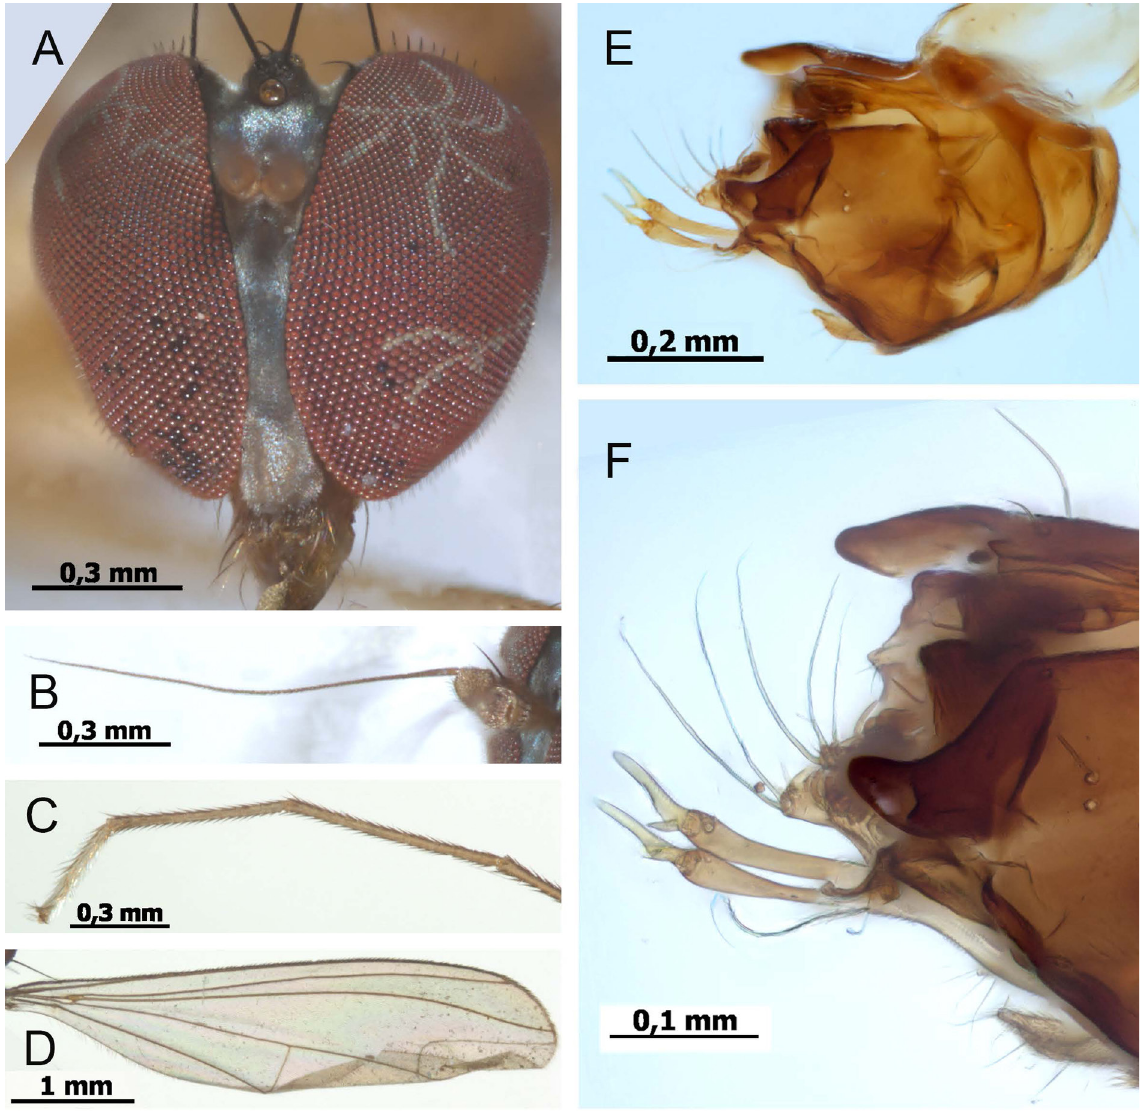
Fig. 12. Amblypsilopus olgae sp. nov. Holotype, ♂ (SMNHTAU). A . Head. B . Antenna. C . Fore tarsomeres 2–5. D . Wing. E . Hypopygium, left lateral view, reflected light. F . Distal appendages of hypopygium, transmitted